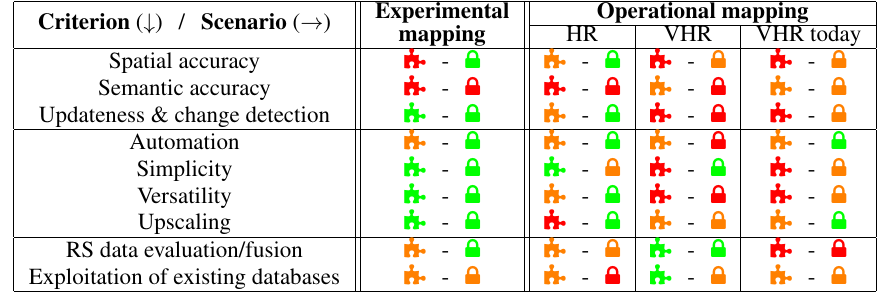
Table 1. Main challenges in land-cover mapping. For operational cases, we distinguish global/High Resolution (HR), national/Very High Resolution (VHR), and VHR with current paradigm change (VHR today). Æ and (cid:181) indicate the importance and the complexity of each criterion, respectively. The color quantifies each of them (low - medium